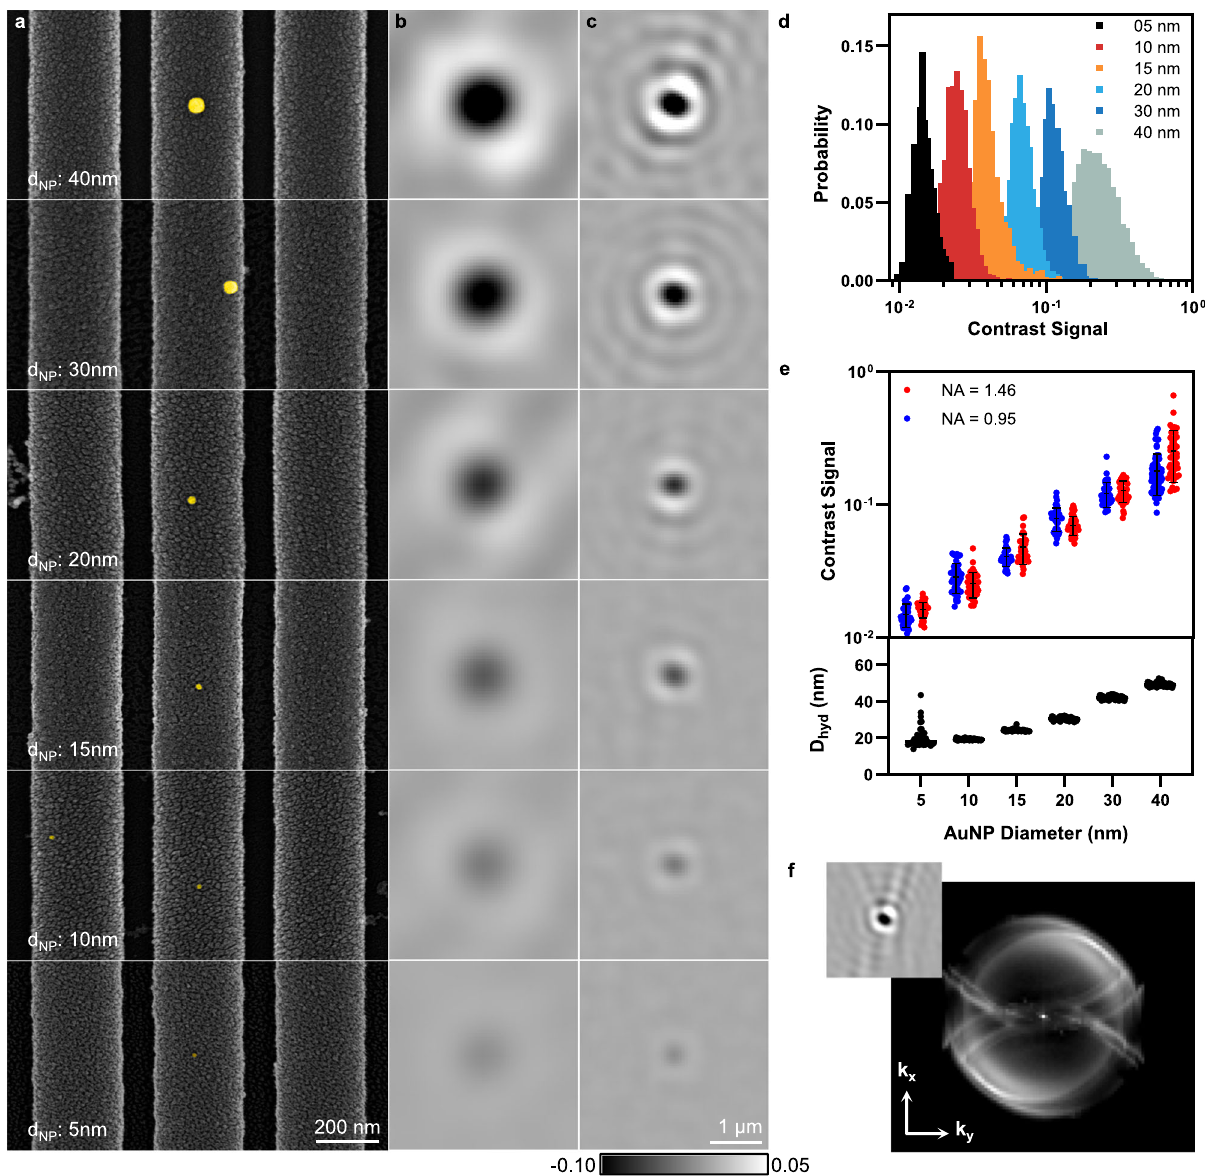
Fig. 3 Imaging experiment with gold nanoparticles. a False-colored SEM images of a PC surface with AuNPs of various sizes. Correspondingly, differential interferometric images are recorded using ( b ) NA = 0.95 and ( c ) NA = 1.46 objectives for the same AuNPs under PRISM modality. d Contrast histogram of AuNP signal distribution obtained using a NA = 1.46 objective. ( n > 500 for each size of AuNP.) The broadening of the contrast distribution for the 40 nm-AuNPs is likely caused by the formation of multiple-particle aggregates. e Scatterplot of the signal contrast as a function of AuNP size. Each dot represents the average of 50 instances of AuNP events. Lower panel: hydrodynamic diameters of the same AuNPs obtained through dynamic light scattering measurement. A clear separation of the hydrodynamic diameter can be except for AuNPs below 10 nm in diameter, where the instability of the laser becomes overwhelming comparing with the weak NP scattering signal. The DLS measurement for each AuNP size was repeated separately fi ve times. f Fourier plane image of the AuNP ( d = 40 nm) scattered light obtained by averaging the 2D Fourier-transformed images over 6000 frames. The outer circle is equivalent to NA = 0.95 in air. Inset: a typical real-space signal pattern of a 40-nm AuNP. FOV: 4.5 μ decay rate γ r with decreasing size; therefore, the PC-enabled scattering cross-section enhancement ratio is also a function of NP size. This volume-dependent relationship is best captured in Fig. 4b, where the ampli fi cation of AuNP scattering cross section by the resonating PC substrate is obtained in comparison with that of a glass substrate. In general, AuNPs exhibit at least one- order-of magnitude enhancement in the scattering cross section, and d e is the effective length of the evanescent fi eld. As the but for smaller NPs ( d AuNP = 5 nm) the cross section can be its radius, the scattering damping rate γ sc approaches the radiative ampli fi ed by as much as 287 times.